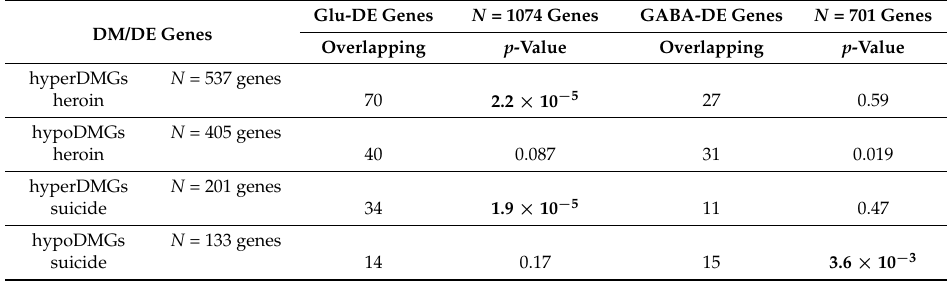
Table 2. Overlap between heroin or suicide DMGs and Glu- or GABA-specific DEGs. The overlaps were calculated separately for hyper- and hypoDMGs. DMGs associated with both hyperDM- and hypoDM sites were not included. Statistical significance was calculated with the hypergeometric test. Significant overlaps ( p -value < 0.01) are shown in bold. Only genes present in both the 450 K array annotation and the DE analysis data set were included in the analysis (13,544 genes). Glu-DE Genes N = 1074 DM/DE Genes